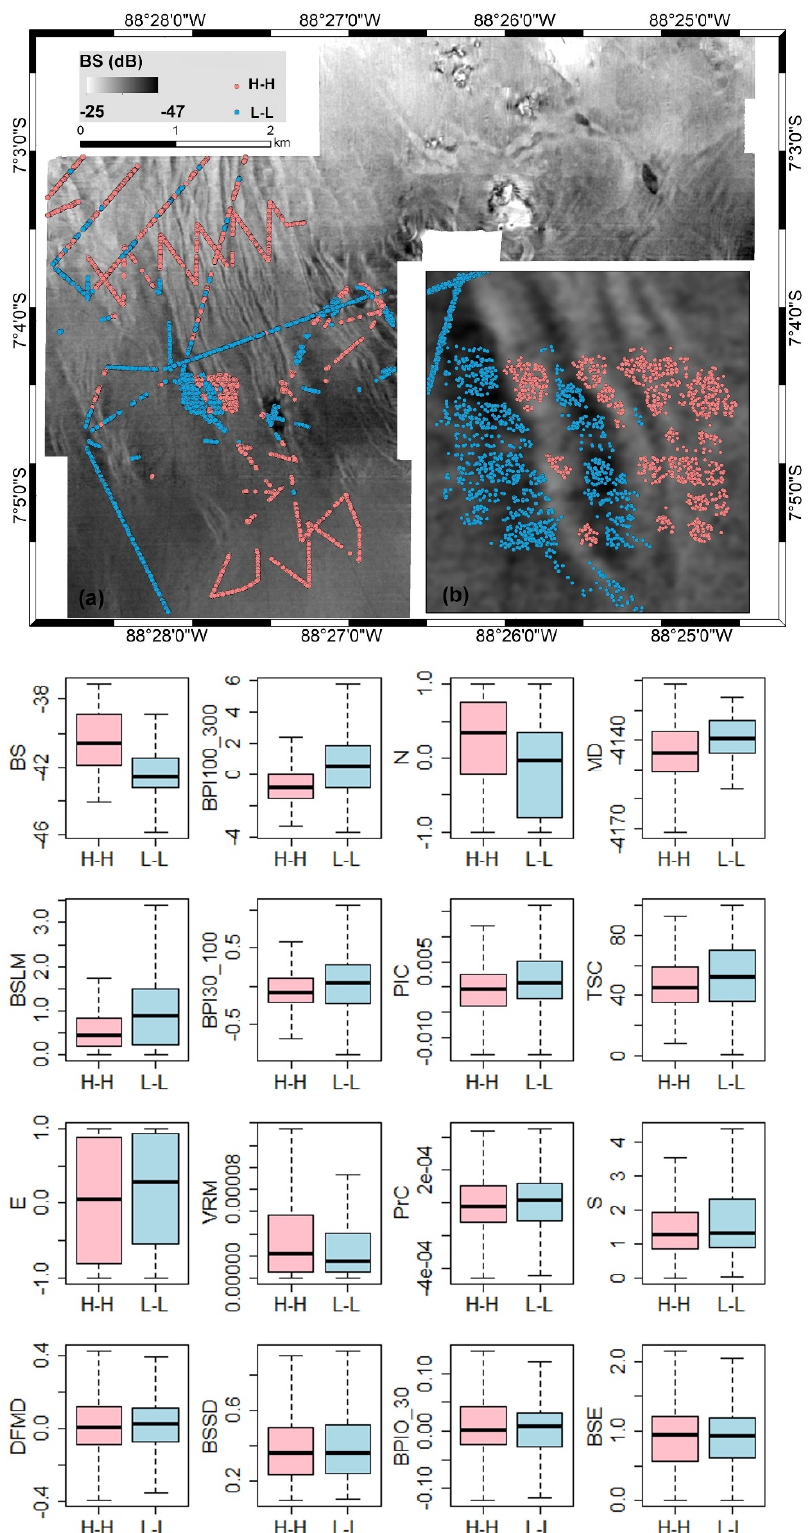
Figure 4. Top: PMN spatial H-H and L-L cluster distribution based on the local Moran’s I analysis. ( a ) The northwest and southeast parts have mainly or exclusively H-H values. Conversely, the eastern part has L-L values. ( b ) The clustering zonation follows the seafloor microrelief (abyssal furrows). Bottom: boxplots between statistically significant spatial clusters and MBES derivatives, showing the differences between H-H and L-L clusters.